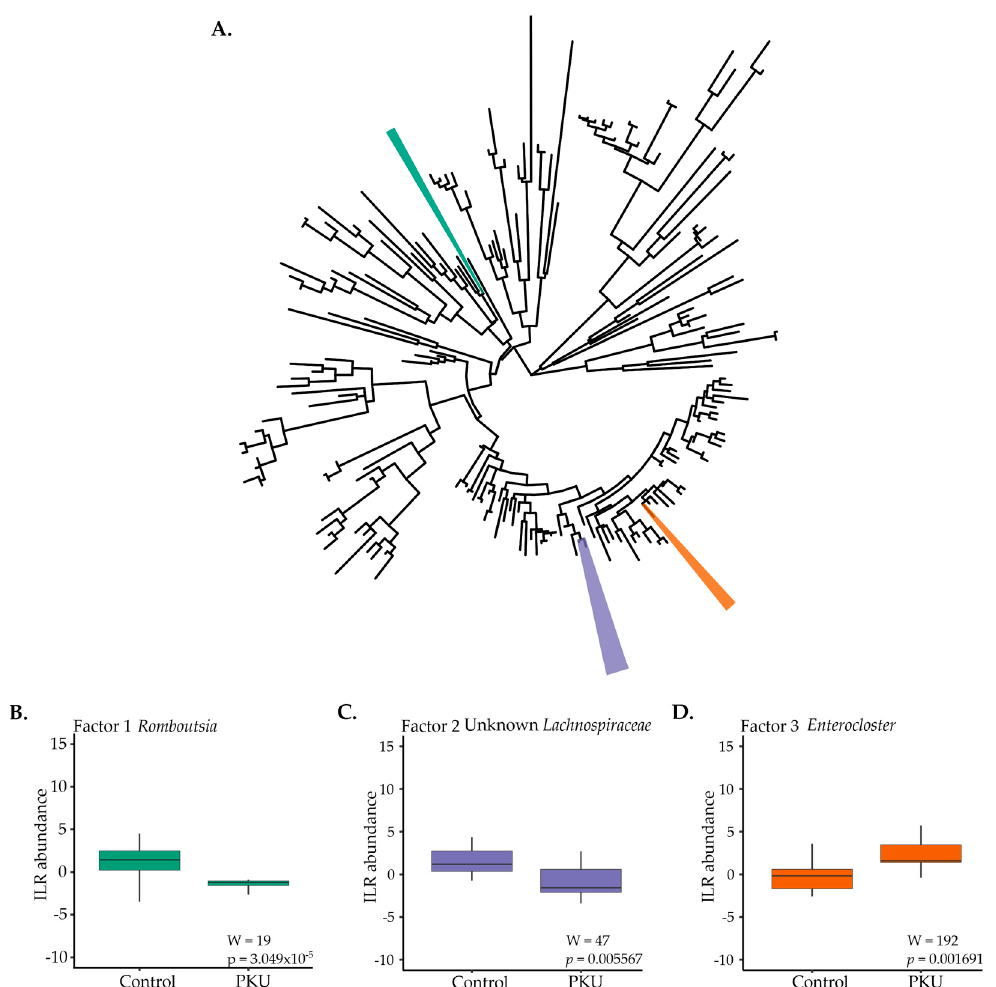
Figure 3. Phylofactorization of all bacterial ASVs present in PKU and control fecal samples ( A ). Three factors were identified as the most influential members differentiating PKU and control samples at the genus level: ( B ) Romboutsia (green), ( C ) two unknown Lachnospiraceae (purple), and ( D ) Enterocloster (orange).